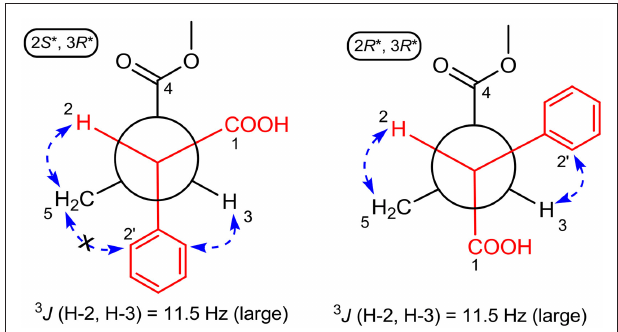
FIGURE 4 | ROESY correlations (dashed blue arrows) and coupling constant were used to determine the relative configuration of 1 by optimized conformation analysis for C-2 to C-3.